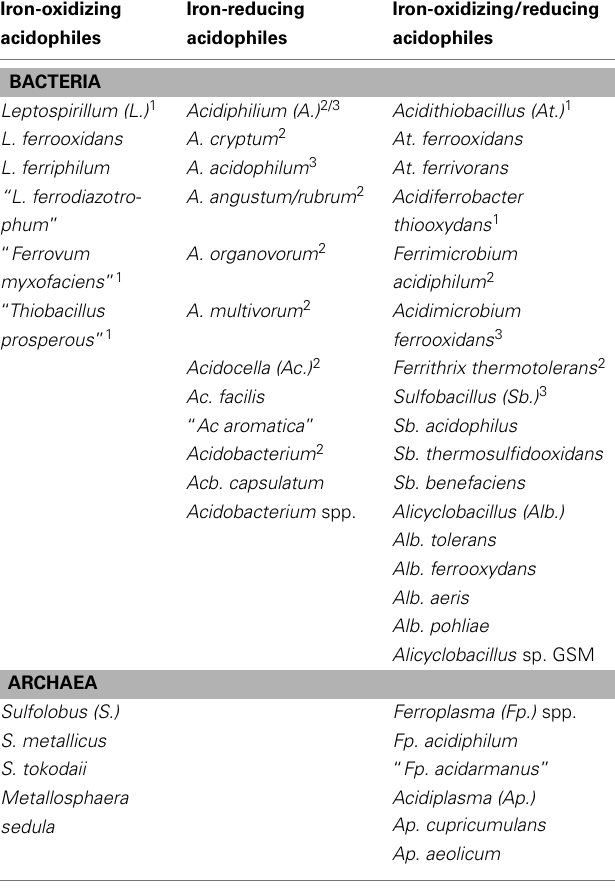
Table 1 |Acidophilic bacteria and archaea that have been reported to catalyze the dissimilatory oxidation of ferrous iron or reduction of ferric